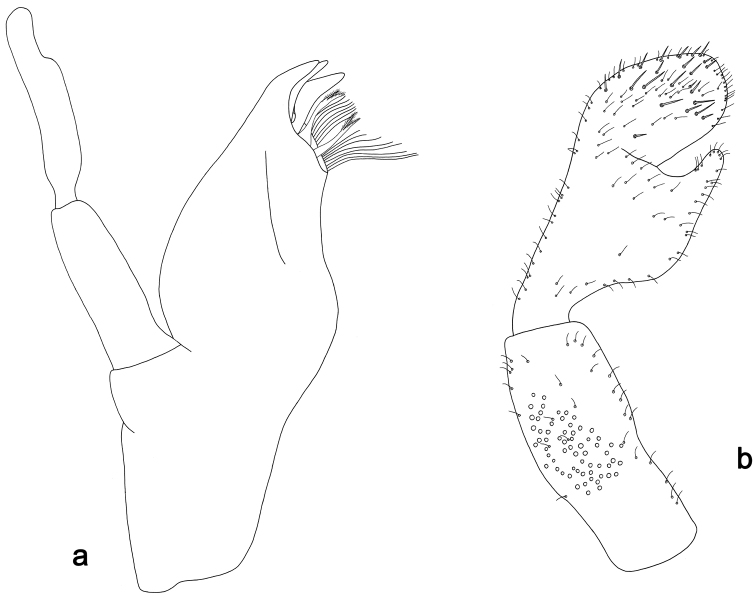
Labiobaetisvultuosus, larva morphology: a Maxilla b Labial palp.